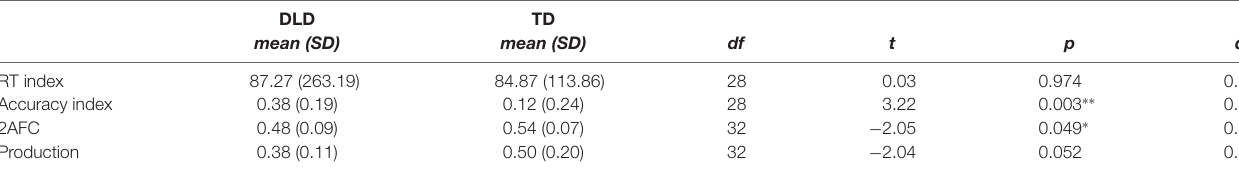
TABLE 5 | Independent-samples t -test analyses for each learning index of the acoustic verbal segmentation task.